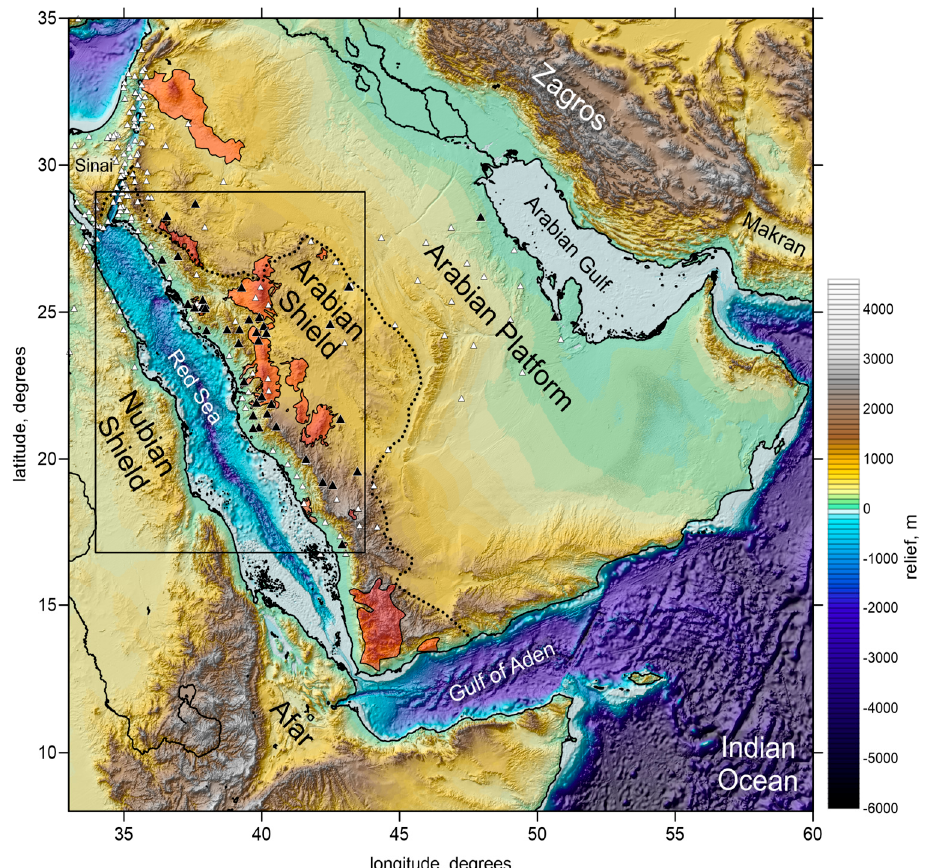
Figure 1. Arabian Plate topography and major geological units. The dotted line indicates the boundary of the Arabian Shield. The red areas highlight the Cenozoic basaltic fields (harrats). The white triangles depict the seismic stations used by [4] to build the tomography model, and the black triangles are those selected in this study for receiver-function method. Rectangle indicates a zone of particular interest of this study.